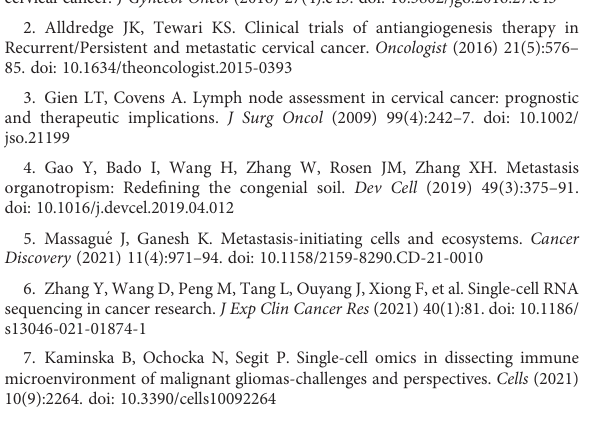
SUPPLEMENTARY FIGURE 2 GO analysis of up-regulated genes in seven epithelial cell clusters. SUPPLEMENTARY FIGURE 3 Functional analysis of up-regulated in different samples. GO analysis of up-regulated genes of tumor cells in non-metastatic tumors (tumors 1 and 2) (A) . GO analysis of up-regulated genes of tumor cells in metastatic tumors (tumor 3) (B) . Venn diagram showing the 120 overlappings of up-